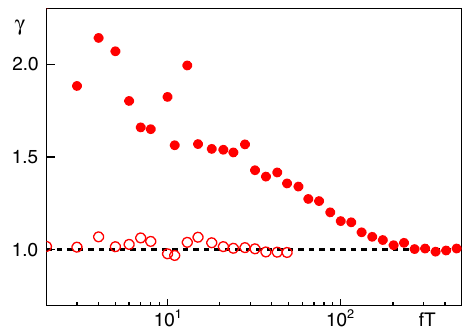
Fig. 3 Coef fi cient of variation obtained from experimental subdiffusive trajectories with a marked anti-persistence. Results from two datasets are shown: experimental tracking of p-granules in C. elegans embryos (open red circles) and telomeres in the nucleus of mammalian culture cells ( fi lled red circles). They both comply with the expectation for subdiffusive data that γ converges to unity (indicated by the black dashed line). In both cases, the MSDs contained a non-negligible static